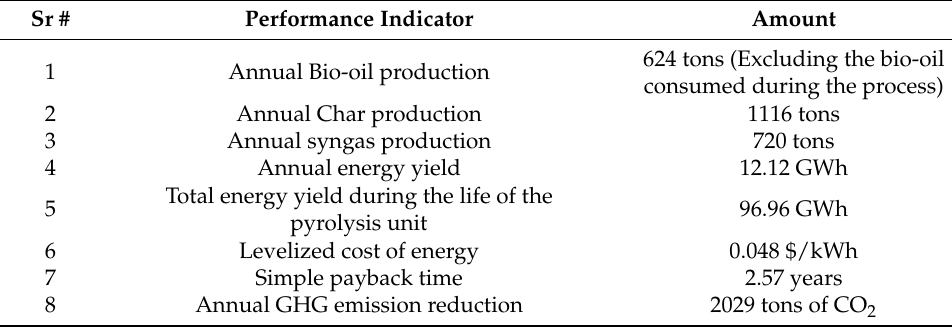
Table 9. Results of other performance